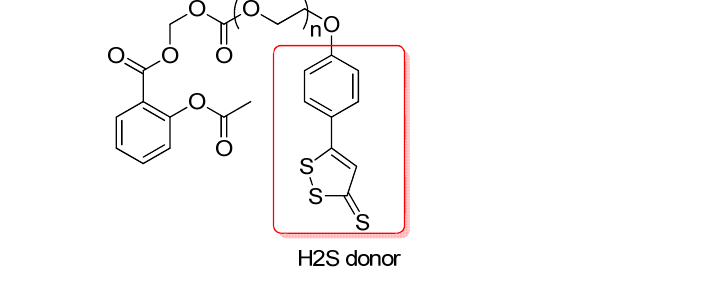
Figure 17. Hybrid of aspirin with H